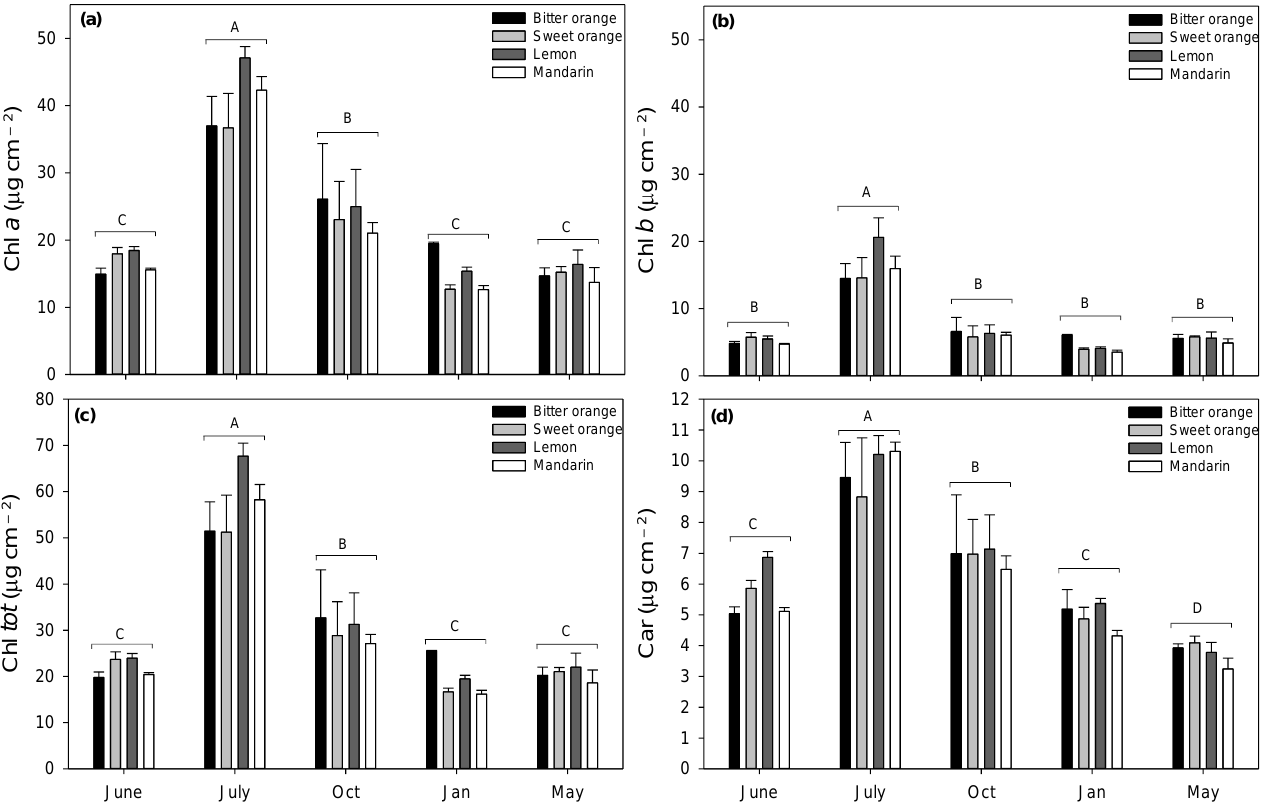
Figure 3. Seasonal variation of leaf content ( µ g cm − 2 ) of ( a ) chlorophyll a (Chl a ), ( b ) chlorophyll b (Chl b ), ( c ) total chlorophylls (Chl tot ), and ( d ) total carotenoids (Car) in Citrus spp. leaves. Data are means ± standard error ( n = 5). Statistics as in Figure 1. Different uppercase letters indicate significant differences among months ( p ≤ 0.05, Fisher’s LSD).